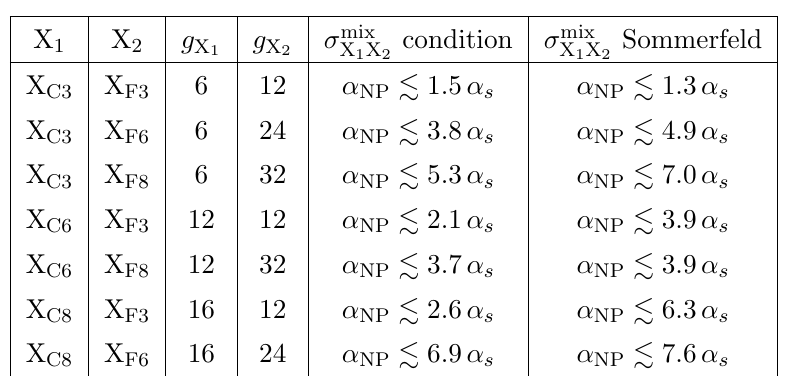
Table 1 . Values of the new physics coupling (cid:11) NP that saturate the mixed condition (3.10) for new physics models where the mixed annihilation is mediated by an interaction with SM quarks. We marginalize over the other relevant parameters g DM , m X and v as described in the main